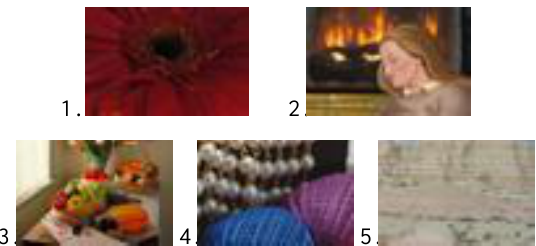
Figure 4 : Examples of 1-5 levels of focal point presence rating, top to bottom and left to right